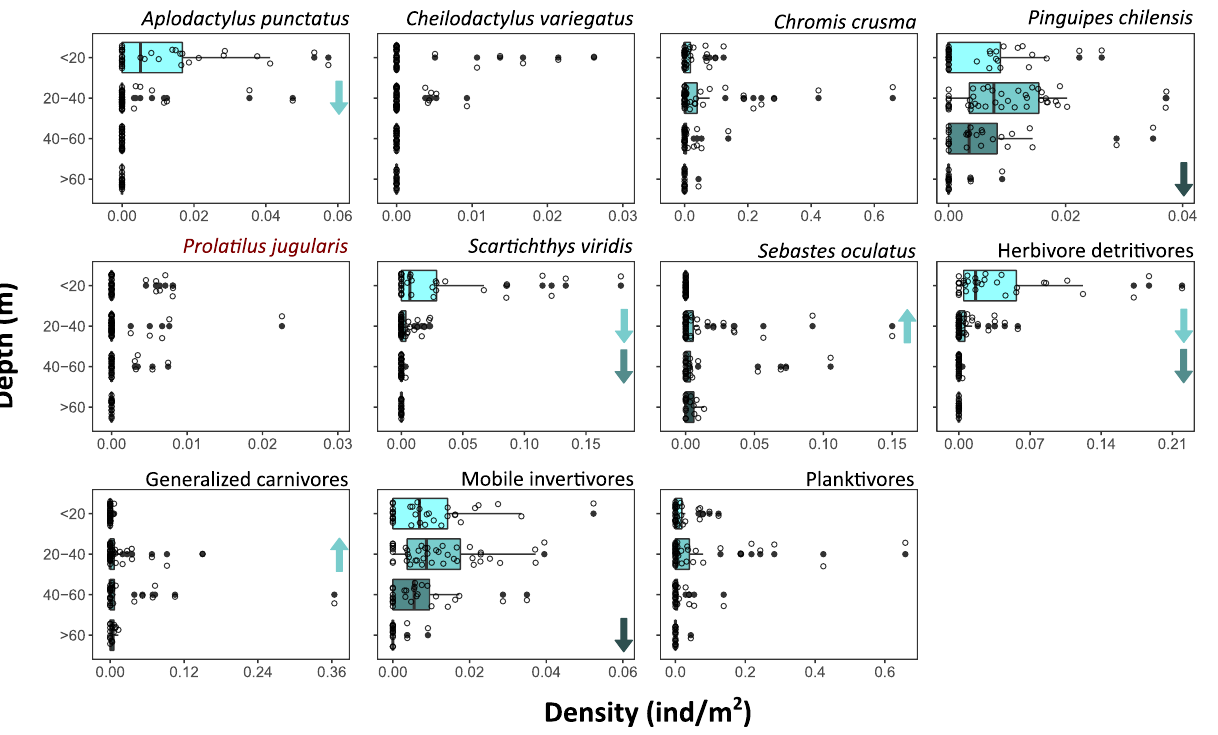
Figure 4. Density of fish species and trophic categories in depth strata. Points are taxa occurrences on video sections; on boxplots: vertical lines indicate median value; boxplot hinges indicate first and third quartiles; boxplot whiskers indicate largest and lower values no further than 1.5 × inter-quartile range from the respective hinge; and data beyond the whiskers indicate outliers. Taxa in red highlight non-significant differences between depth strata (Kruskal–Wallis rank sum test, p -value < 0.05). Arrows indicate significant increases or decreases regarding the immediate shallower depth category as given by pairwise comparisons. Table 3. Permutational multivariate analysis of variance (PERMANOVA, 999 permutations, based